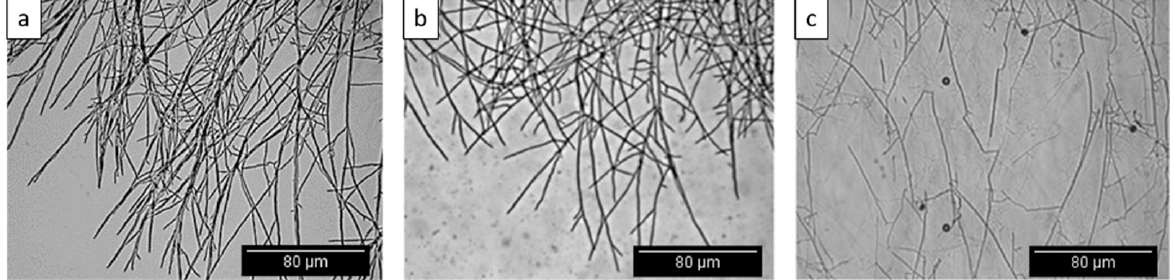
Figure 2. ( a ) Morphology of the uninoculated S. indica hyphae (control). ( b ) Fungal morphology in the presence of K. radicincitans. ( c ) Fungal morphology in the presence of C. fungivorans .